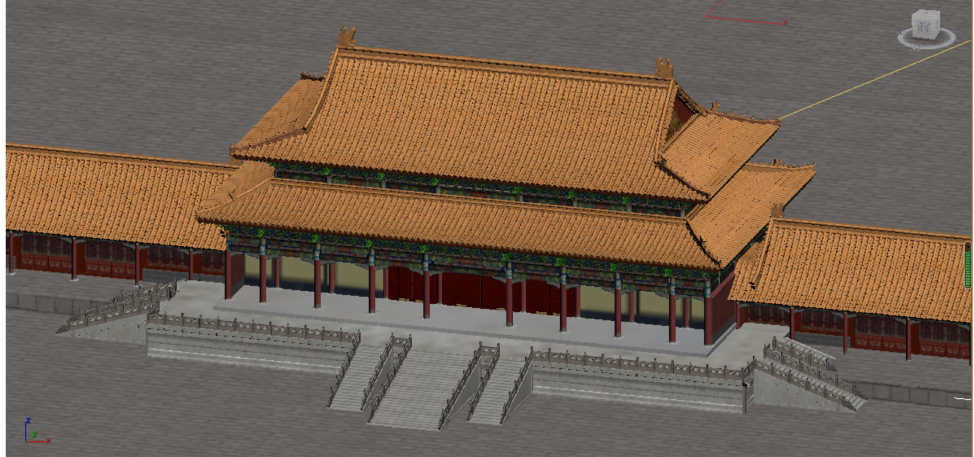
Figure 15. The final 3D model of the Gate of Supreme